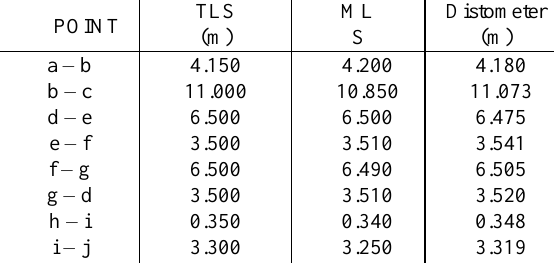
Figure 10: Points of measurement. Table 2: Result of distance measurement.